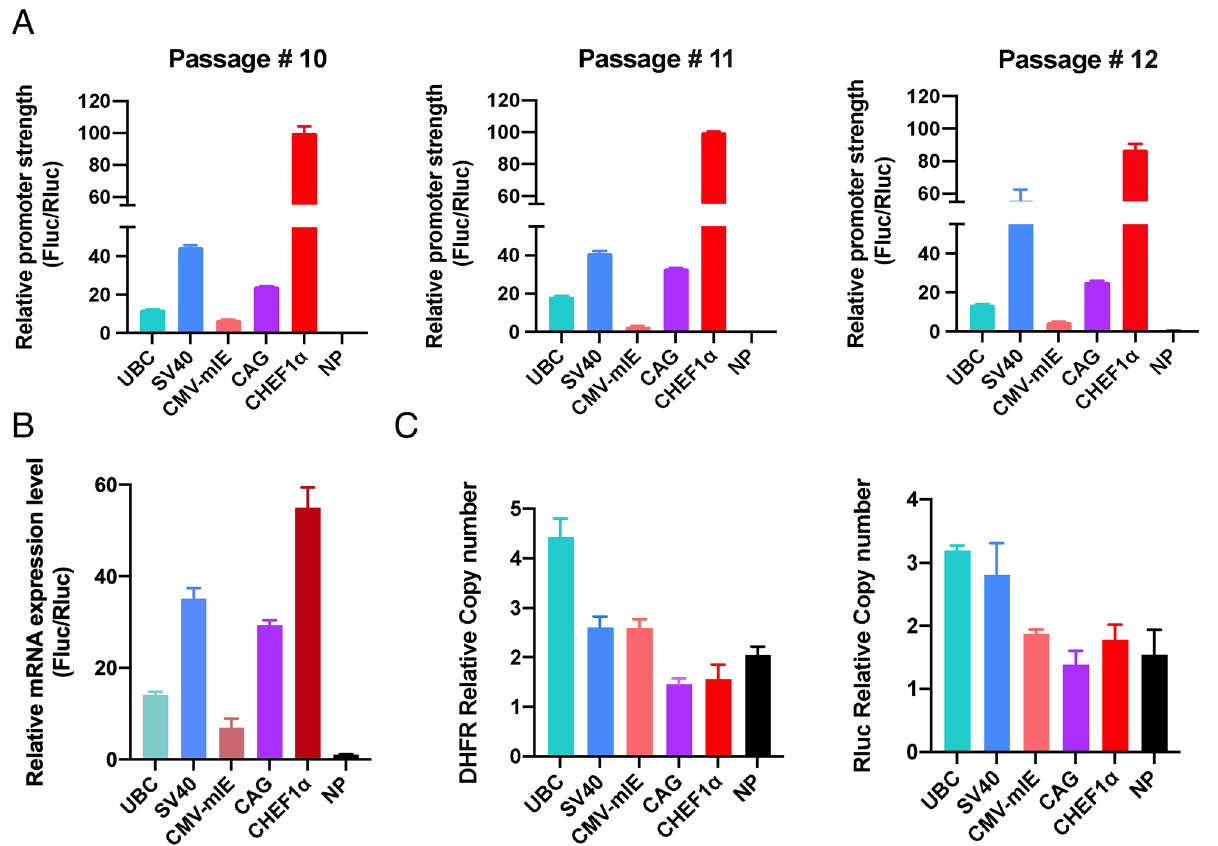
Figure 6. Validation of the vector toolkit in stable transfectants of CHO-DG44 cells. ( A ) Luciferase activity in stable CHO-DG44 pools electroporated with the select panel of vectors (UBC, SV40, CMV-mIE, CAG, CHEF1α and NP). Luciferase assay was carried out in three consecutive passages (Passage 10 to 12), and each promoter activity was concurrently assessed. Quantification of promoter strengths were carried out by dividing the Fluc signal to the Rluc signal. ( B ) mRNA expression of Fluc and Rluc genes was verified by qRT-PCR. Much like the luciferase assay results, CHEF1α yielded the highest transcriptional activity in the stable transfection setting, while CMV-mIE displayed the lowest promoter efficacy. ( C ) Relative DHFR and Rluc copy numbers were calculated according to the internal control gene, GAPDH. Bright Green Master Mix was used for both qRT- PCR assays ( B ) and transgene copy number analysis by qPCR ( C